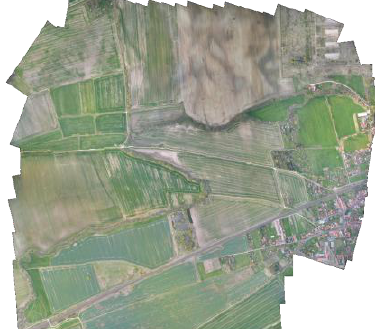
Figure 11. A ANDROMEDA 250 Photograph Mosaic (Krüger et al., 2010)